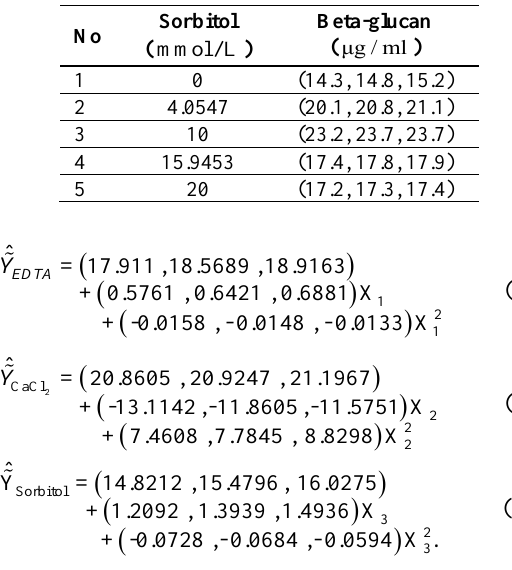
Table 8. Fuzzy data set for Sorbitol and BG.